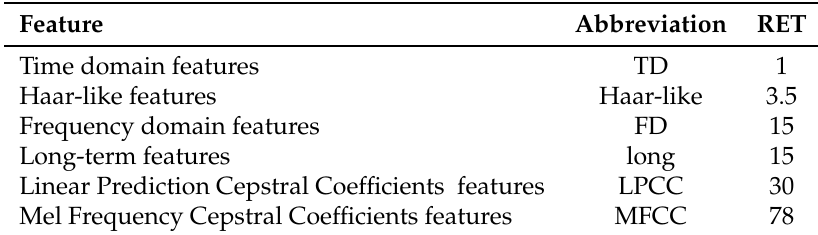
Table 2. Relative execution time